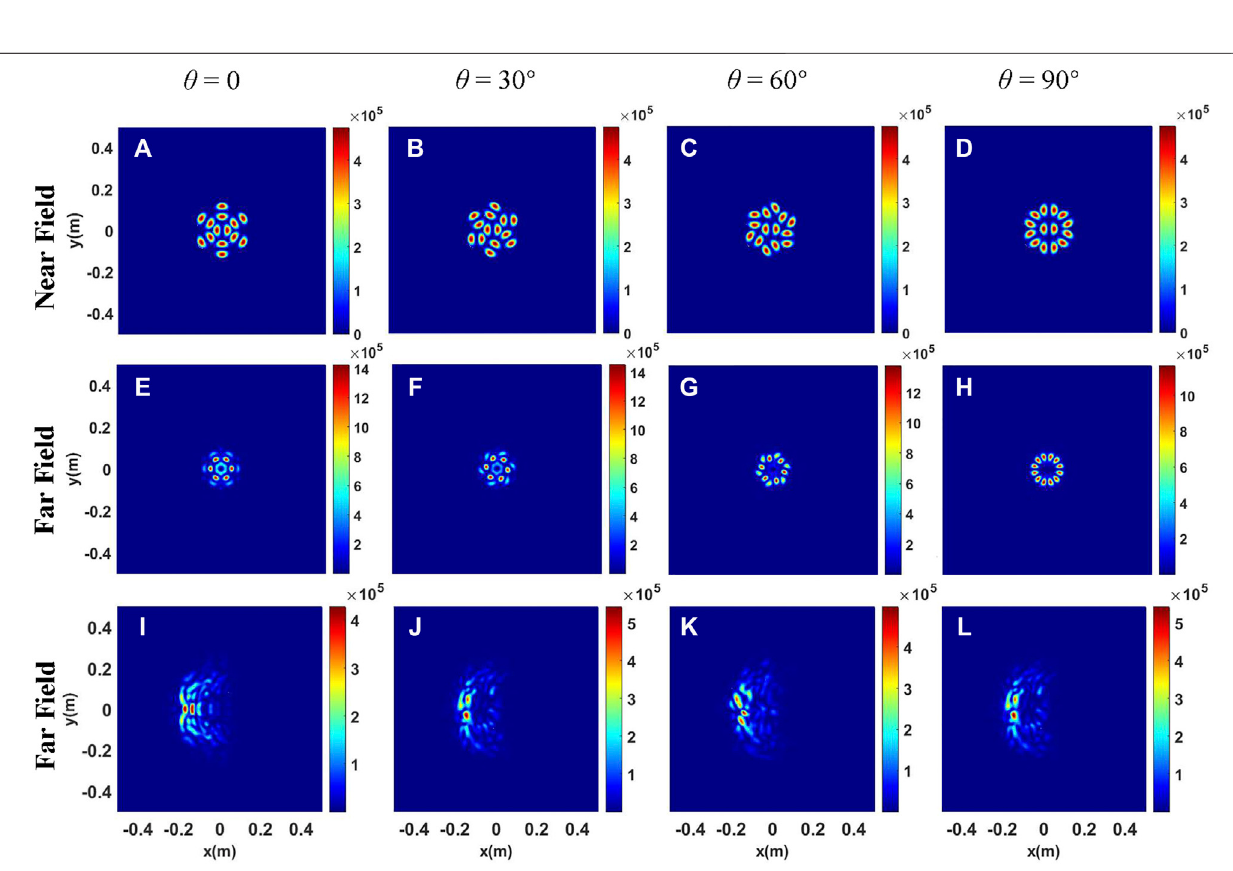
Frontiers in Physics |